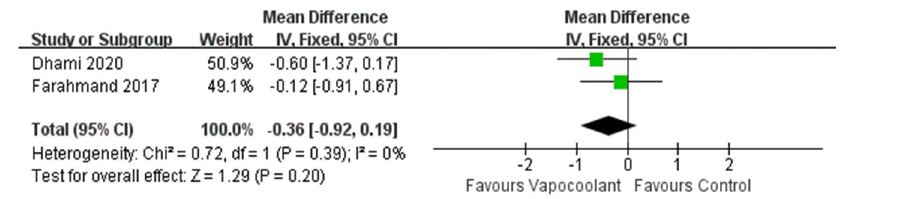
Fig 3. Forest plot of pain scores during artery puncture.